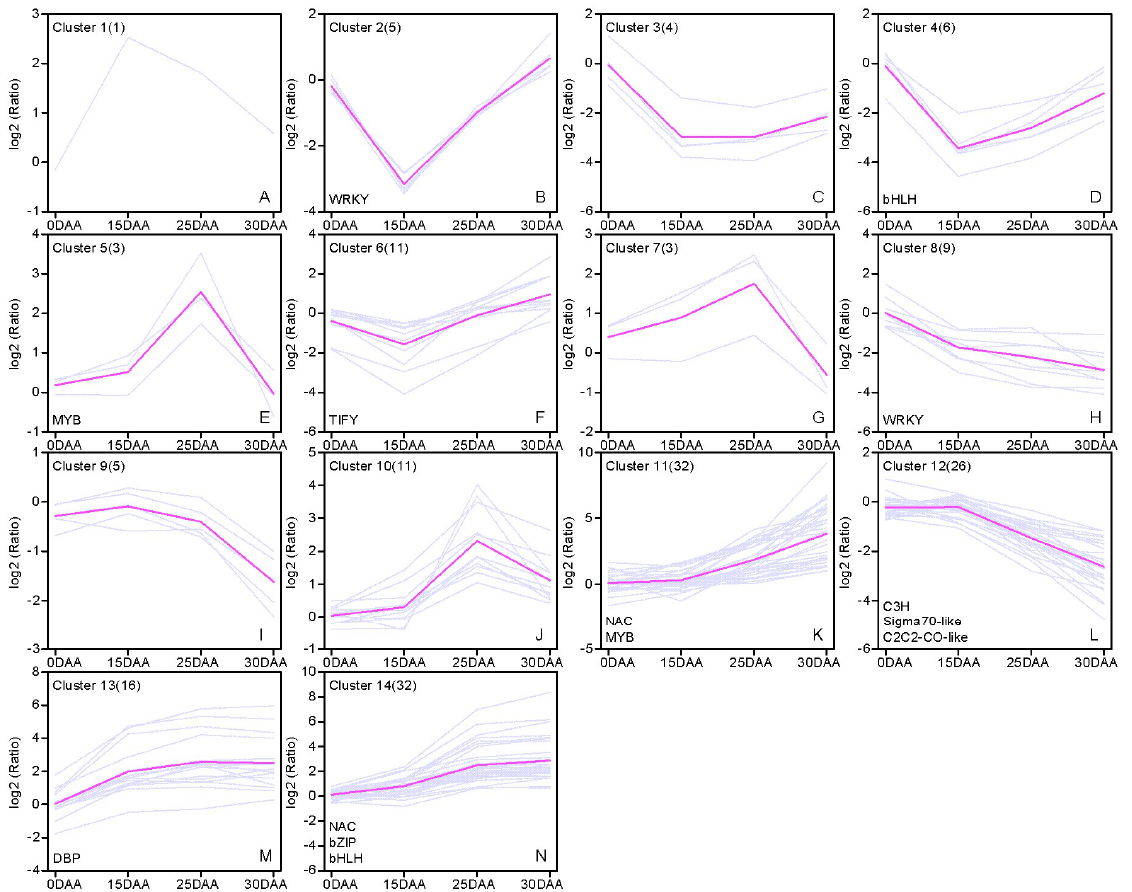
Figure 4. Cluster analysis of differentially expressed transcription factor genes. ( A – N ) The expression pattern of transcription factors of different families in the 0–15 DAA, 15–25 DAA, and 25–30 DAA period. Different colorful lines show the overall trend of genes expression in three periods. TF families are noted in the cluster where most of their members belong. The figure in parentheses indicates the gene number in the group.